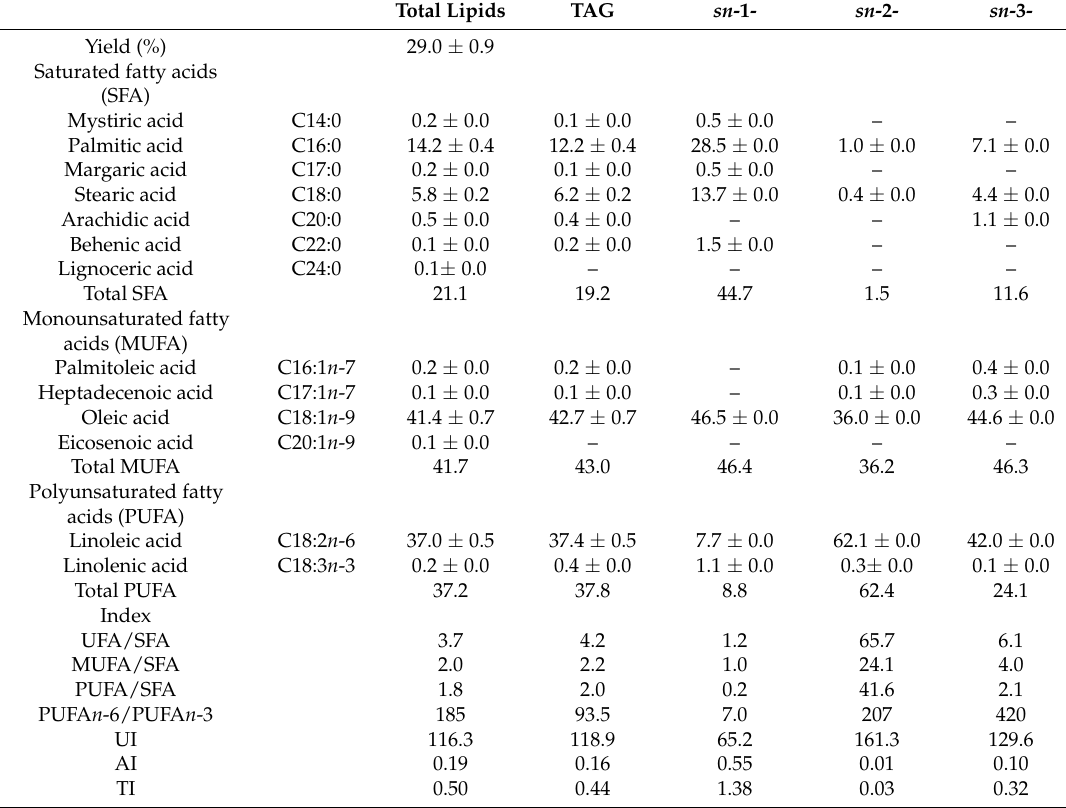
Table 2. Total and intrapositional % fatty acid composition (% mol, mean value ± SD, n = 3) of oil and triacylglycerol (TAG) fraction of pumpkin ( C. maxima , var. Berrettina) seed oil. Total Lipids TAG sn -1- 29.0 ±